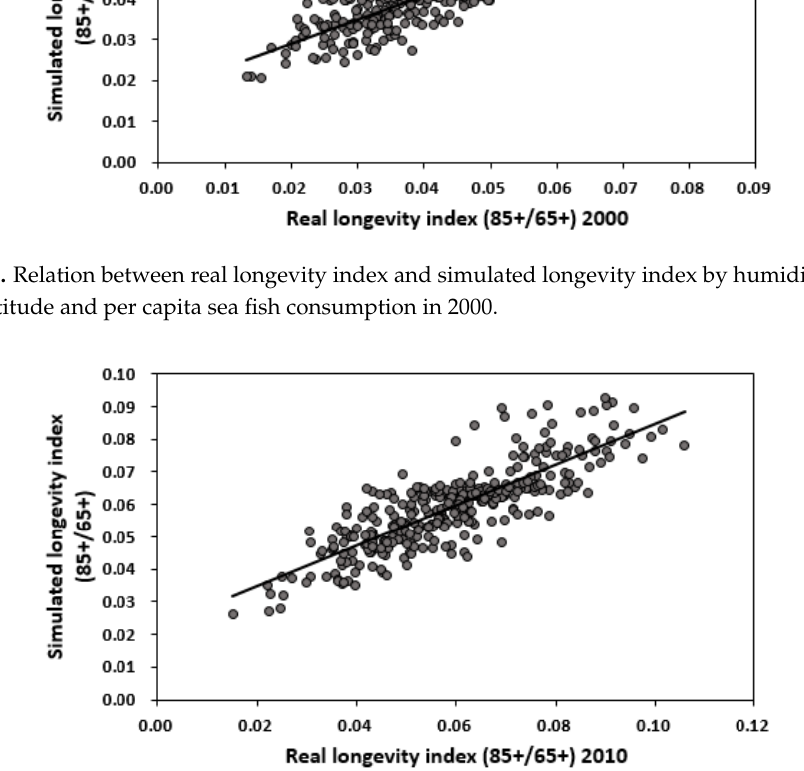
Figure 16. Relation between real longevity index and simulated longevity index by humidity content